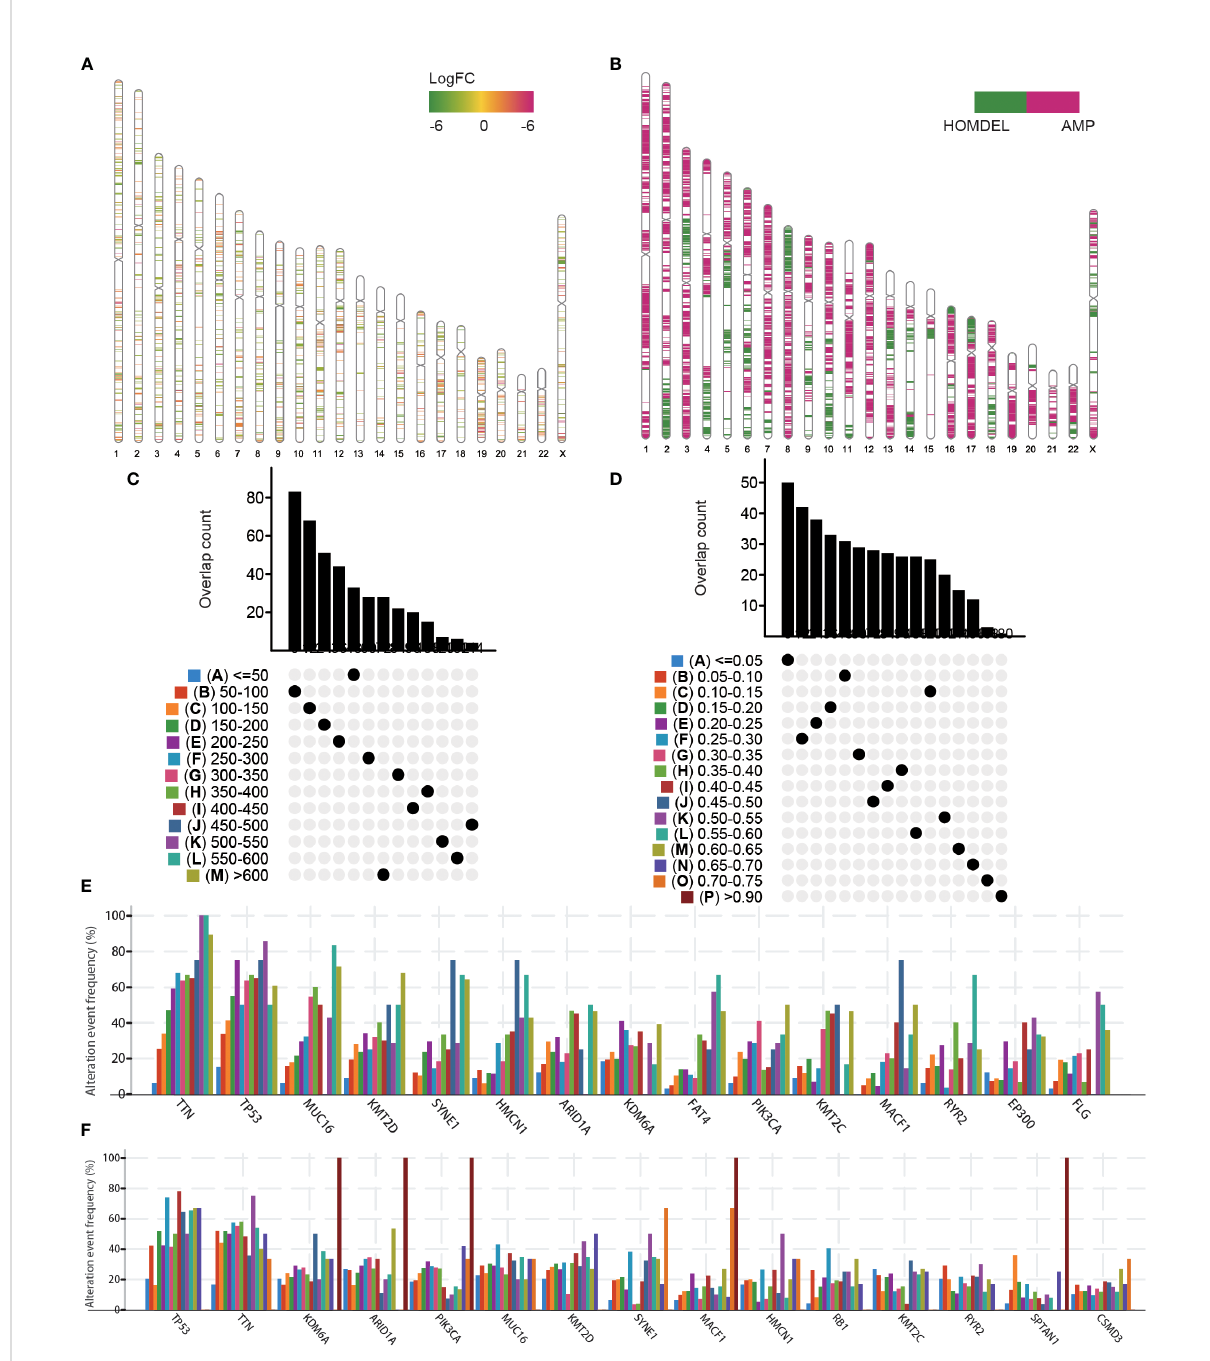
FIGURE 1 Identi fi cation of potential tumor antigens in BLCA. (A) Chromosomal distribution of the overexpressed genes in BLCA. (B) Chromosomal distribution of the aberrant copy number genes in BLCA. Overlapping mutated genes distributed in the fraction genome altered group (C) and mutation count group (D) were shown. Genes with the highest frequency in the fraction genome altered groups (E) and mutation count groups (F) were individually